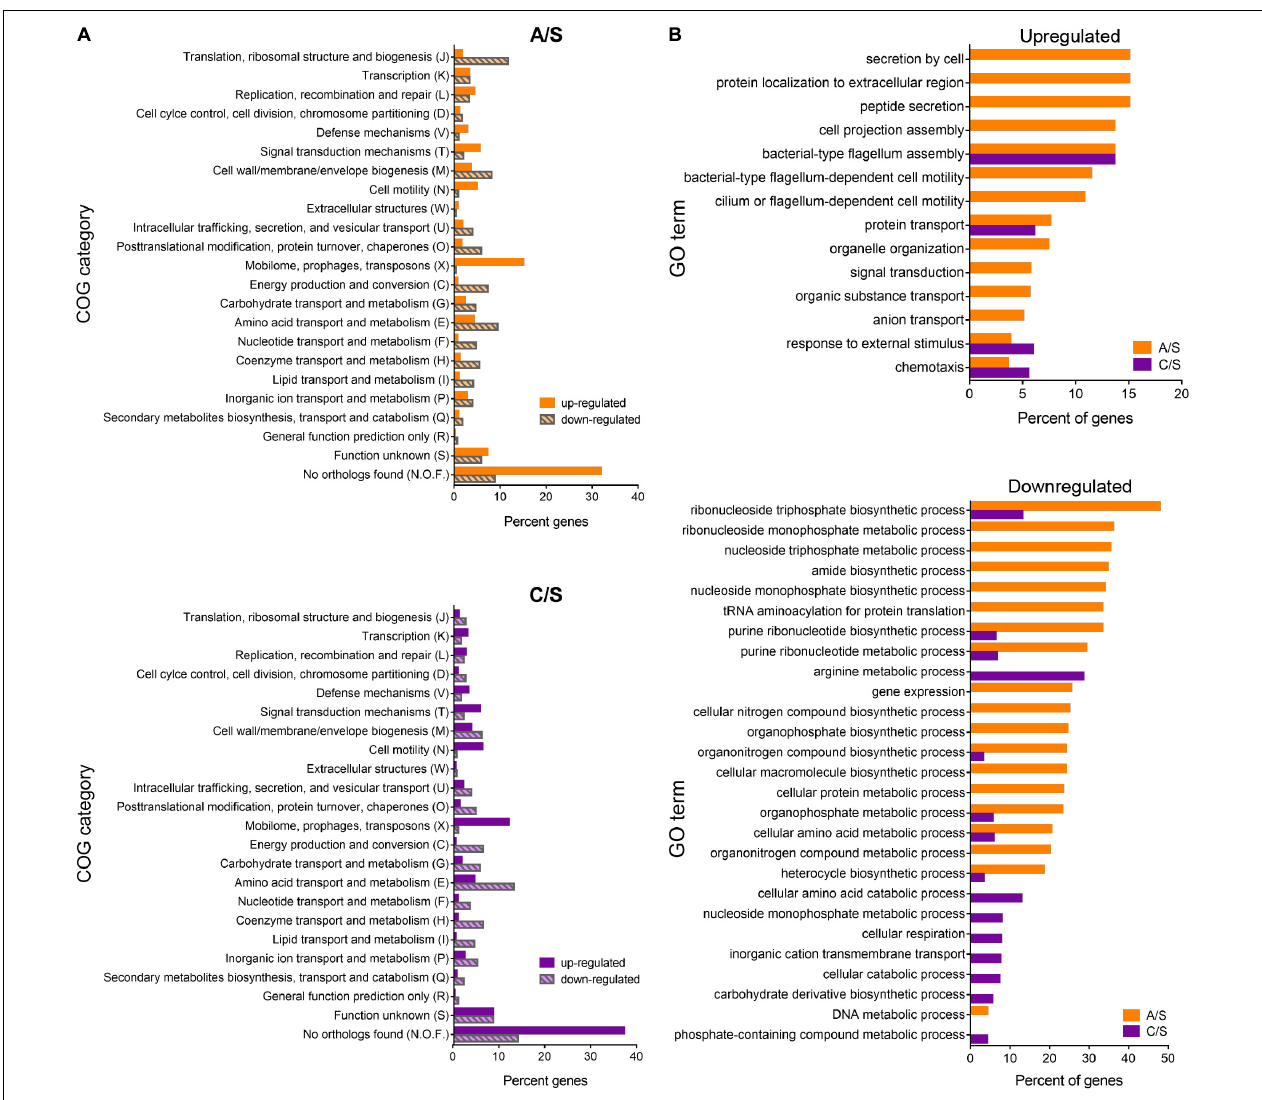
FIGURE 8 | Differentially expressed genes classified into biological and functional gene categories. (A) Functional categories of P. salmonis genes. Percent of differentially expressed genes in each COG (Cluster of Orthologous Groups) identified by total RNA sequencing for the exponentially growing bacteria in the comparisons CMMAB with ampicillin vs. Austral-SRS (A/S, orange), and CMMAB without ampicillin vs. Austral-SRS (C/S, purple). (B) Enrichment analysis of differentially expressed genes. Percent of genes categorized in significantly enriched GO terms are shown for up- and downregulated genes (top and bottom panels,